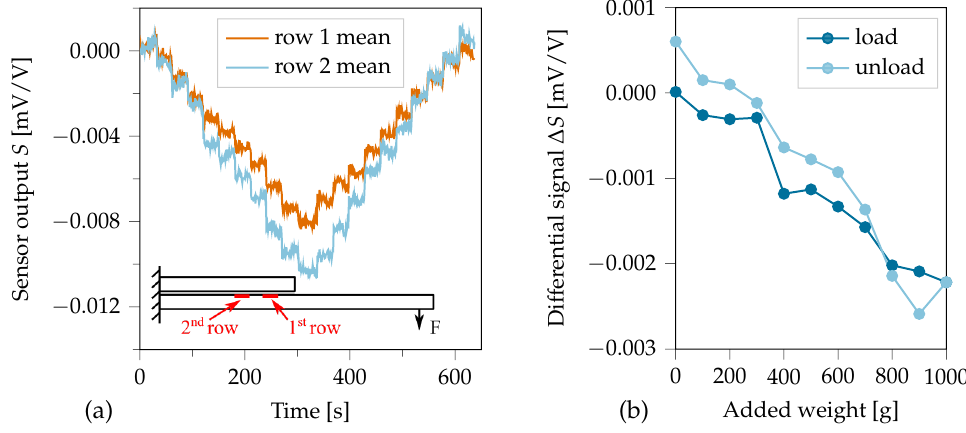
Figure 14. Signals observed in cantilever testing. ( a ) Sensor signals over time, while 100g weights were added to and removed from the cantilever tip with 30s intervals. The little insert shows a side-view sketch of the specimen indicating the positions of the acting force and of row one and two sensors. ( b ) The differential sensor signal ∆ S = S row 2 S row 1 −